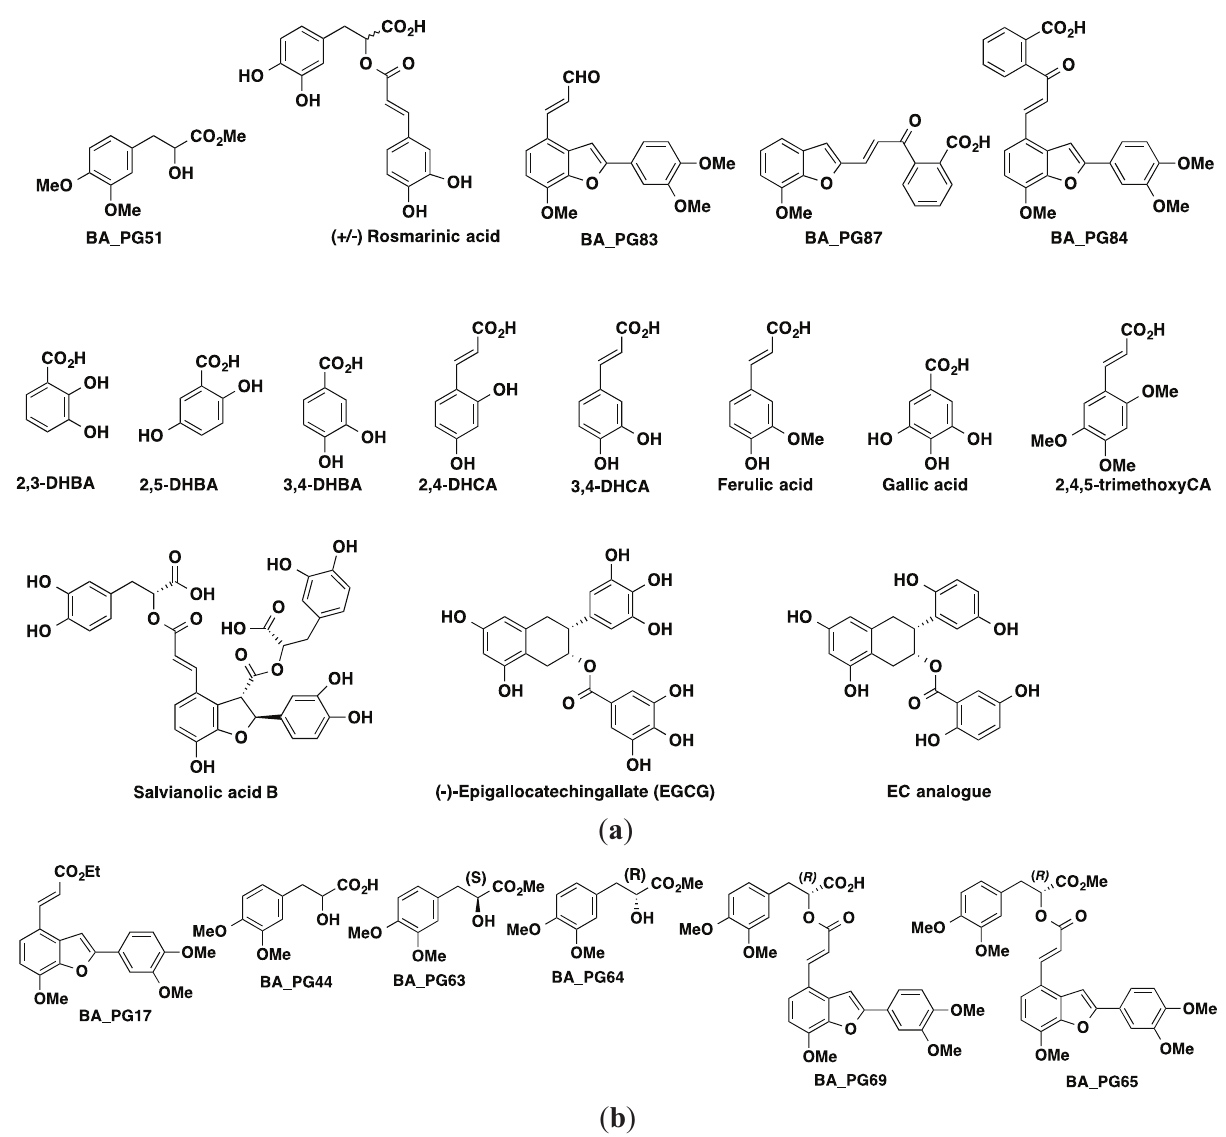
Figure 2. Chemical structures of analyzed polyphenolic compounds. ( a ) Compounds that reduced ThT associated fluorescent similar to EGCG; ( b ) compounds that were not found to be potent inhibitors of amyloid